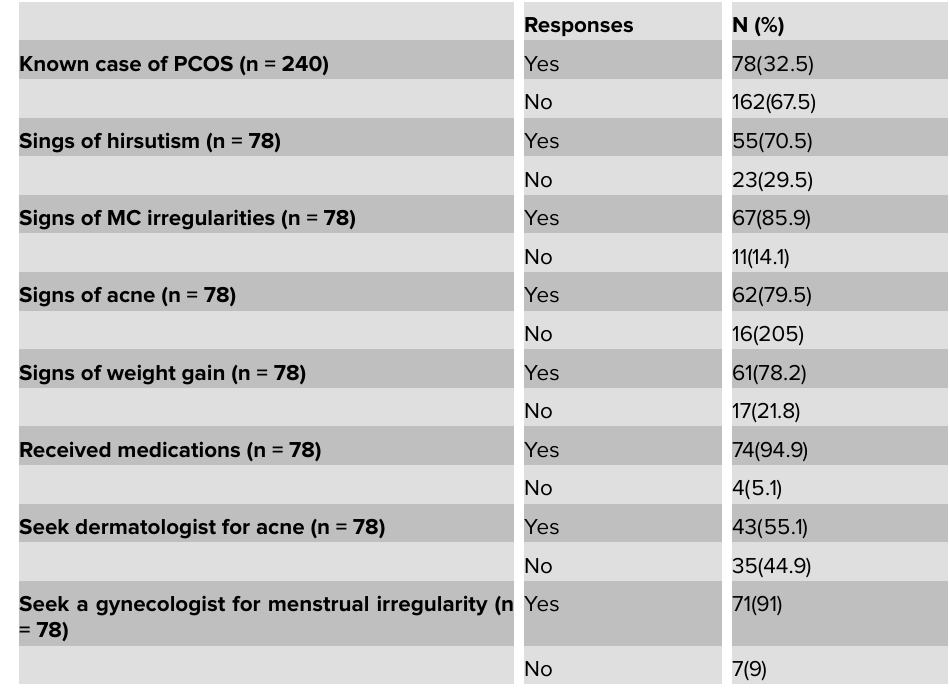
Table 3: Prevalence and practice of PCOS among the participants ( n = 240).